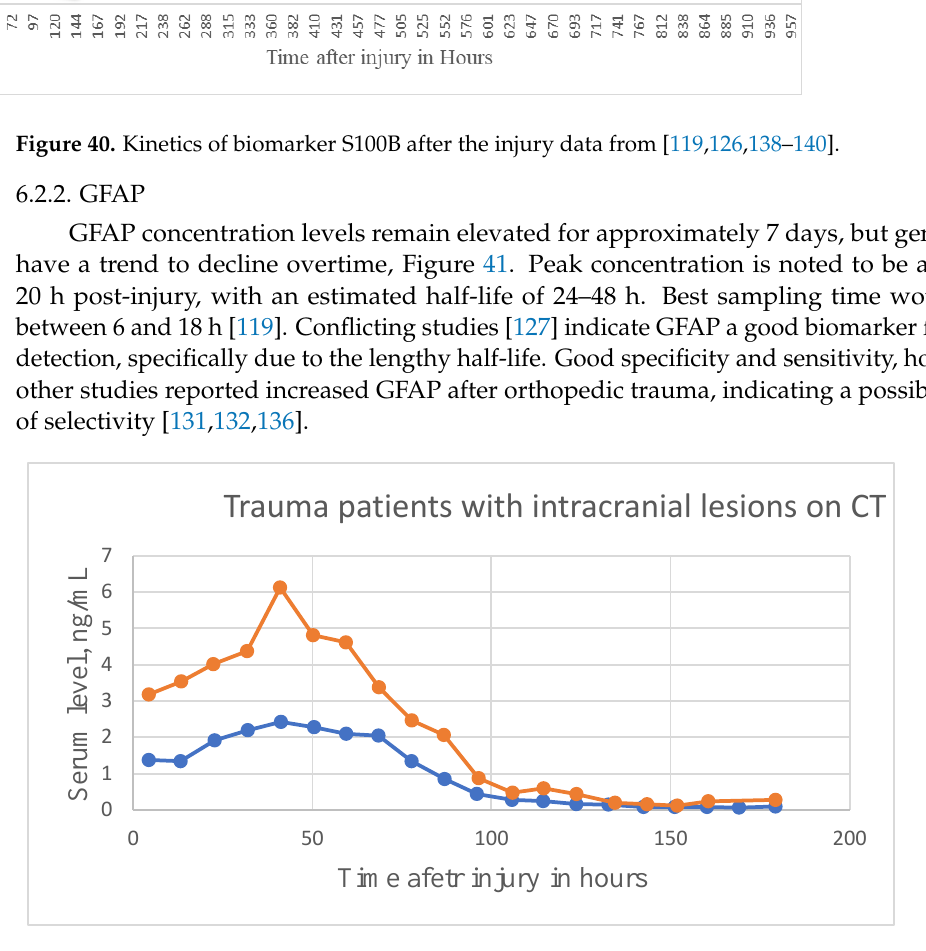
Figure 41. Temporal profiles of GFAP in trauma patients with mild or moderate TBI with surgical intervention and blue line indicates the presence of lesion in CT (data from [141]).